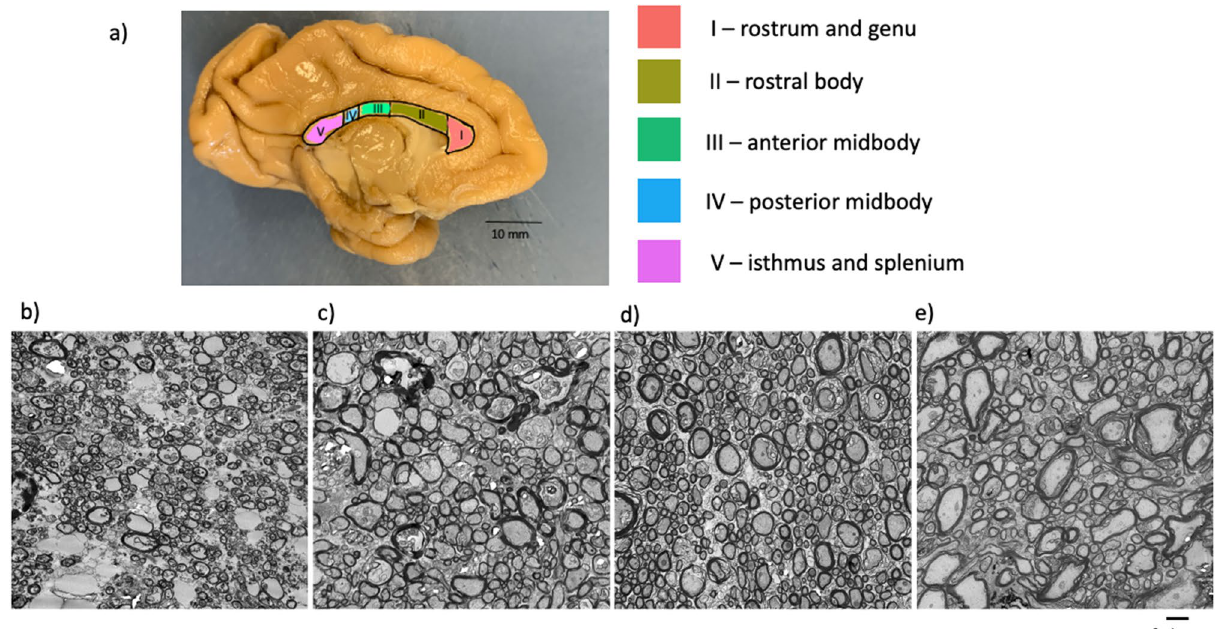
Figure 1. ( a ) The corpus callosum of a capuchin ( Sapajus [ Cebus ] apella ), indicating the five regional subdivisions (I–V). Electron micrographs of myelinated axons in Region V of subjects at ( b ) 0.55 years, ( c ) 5.60 years, ( d ) 9.90 years, and ( e ) 35.40